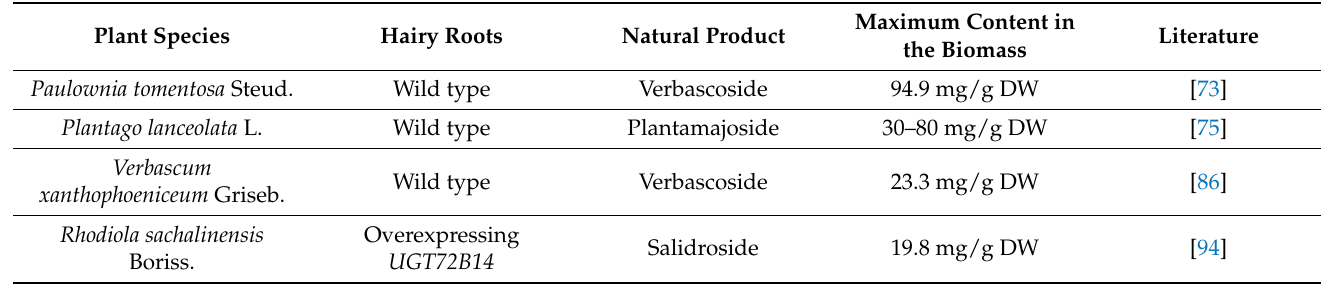
Table 2. Hairy root cultures that produced high yields of